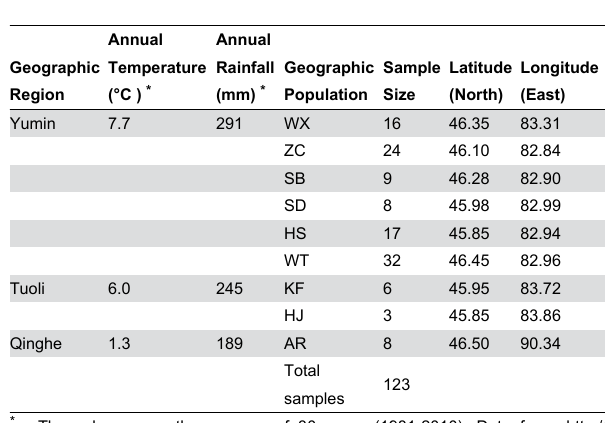
Table 1. Geographical and climatic data of the P. eryngii var. tuoliensis